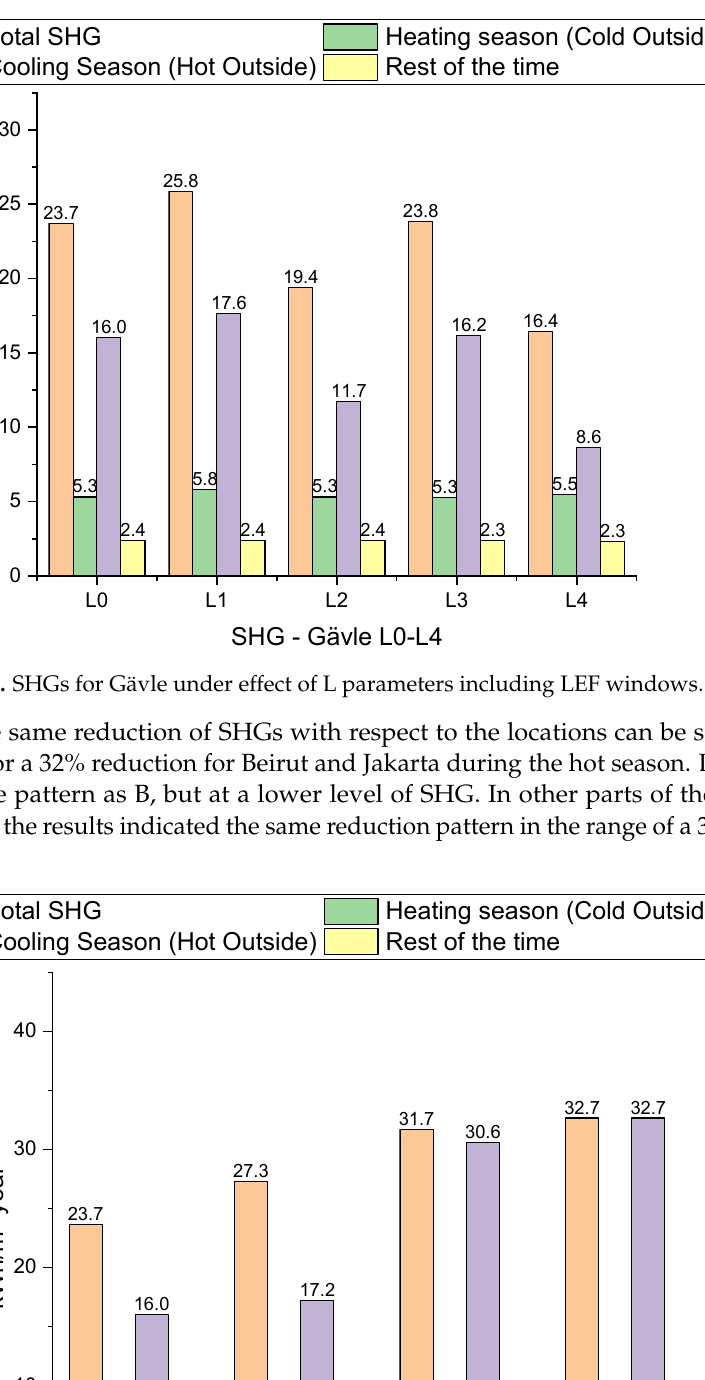
Figure 18. SHGs for L0 in different locations.